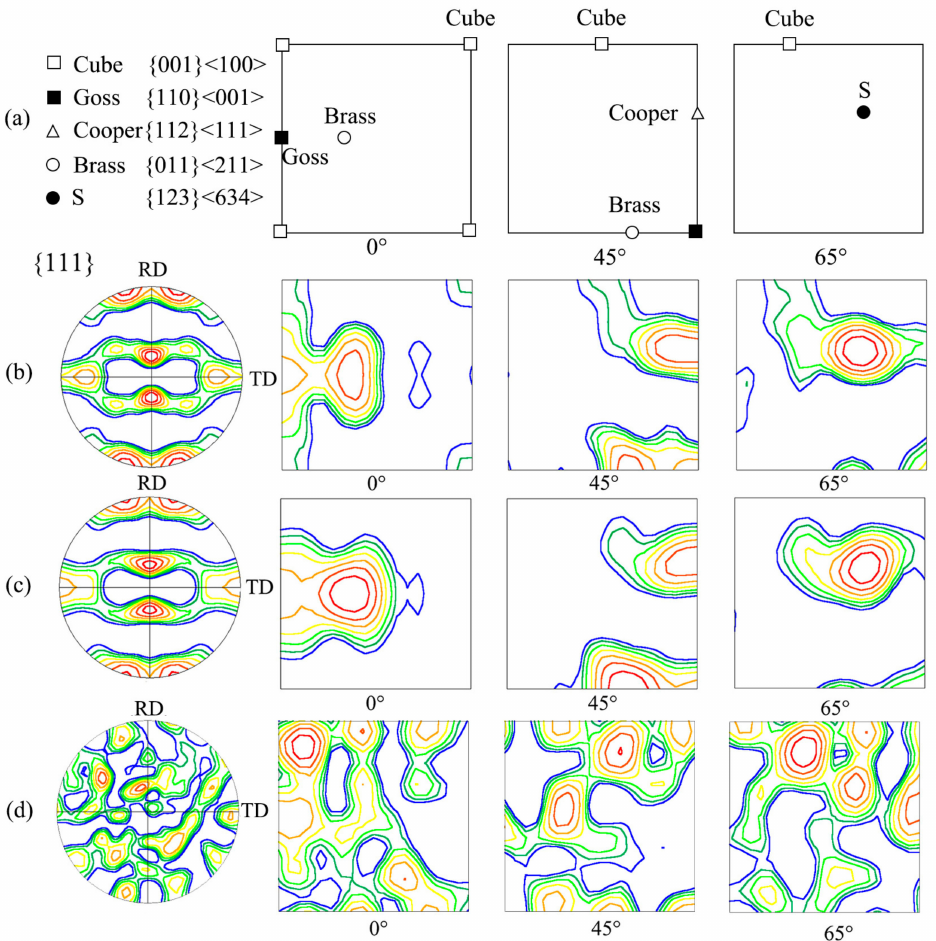
Figure 5. Textures corresponding to the orientation maps presented in Figure 4 in ( b ) 200 ◦ C, ( c ) 300 ◦ C and ( d ) 350 ◦ C. ( a ) shows the ideal texture components of FCC metals [26]. The results were